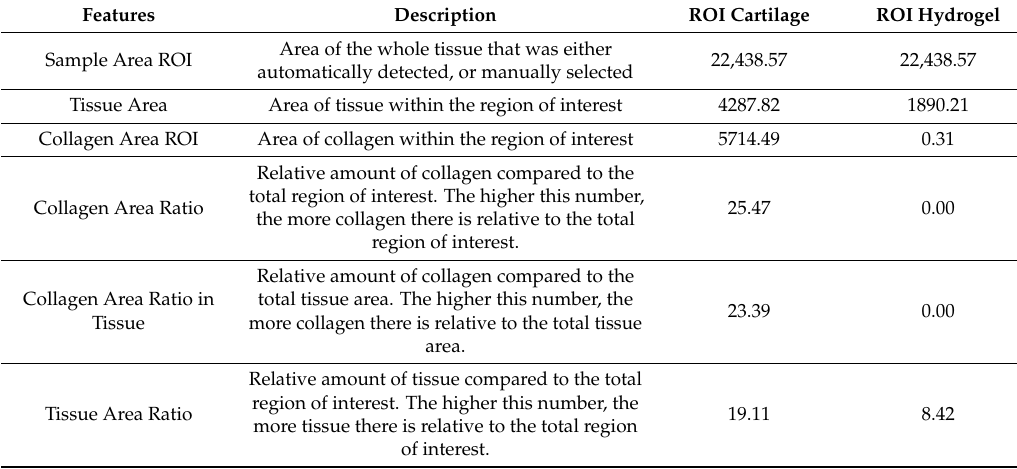
Figure 6. Representative image acquired with non-linear microscopy using the Genesis system on unlabelled 10 μ m cryosections. The super-imposed signals of second harmonic generation (SHG) (green channel) and two-photon excitation (TPE) (red channel) are shown ( A ), while the single channels in ( B , C ). The 2 regions of interest (ROI)’s in the cartilage and hydrogel layers correspond to the regions where the FibroIndex ™ analysis was performed. ( D – D ’’’ ) Detail of the ROI of the cartilage area in A used to elaborate and obtain the parameters with FibroIndex TM software, which were listed in Table 2 (ROI cartilage). Table 2. The lists of the most significant features detectable by the software FibroIndex™ is here reported. As an example of the sensitivity and performance of the software, we analyzed and compared two regions of interest (ROI, see Figure 6) respectively in the cartilage layer and in the hydrogel acellular